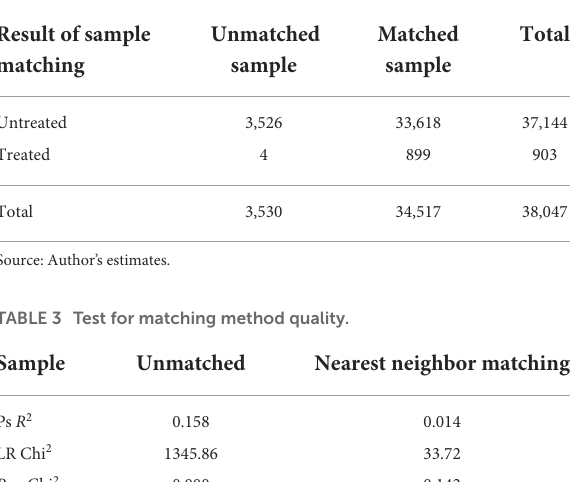
TABLE 2 Sample matching results.